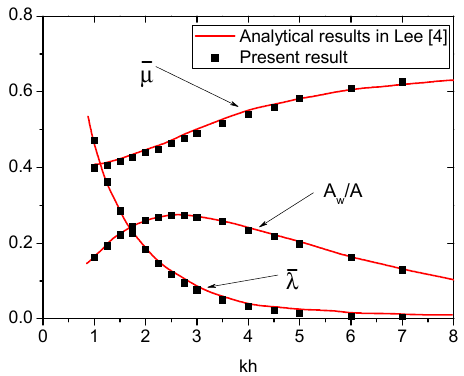
Figure 6. Comparison of dimensionless added mass, damping coefficients and wave amplitude with analytical solution in Lee [4].